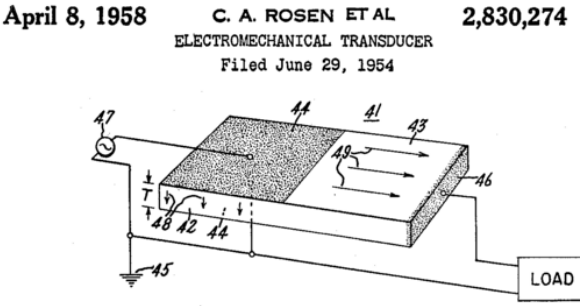
Figure 3. Rectangular piezoelectric transformer presented by Rosen in 1954 [13].